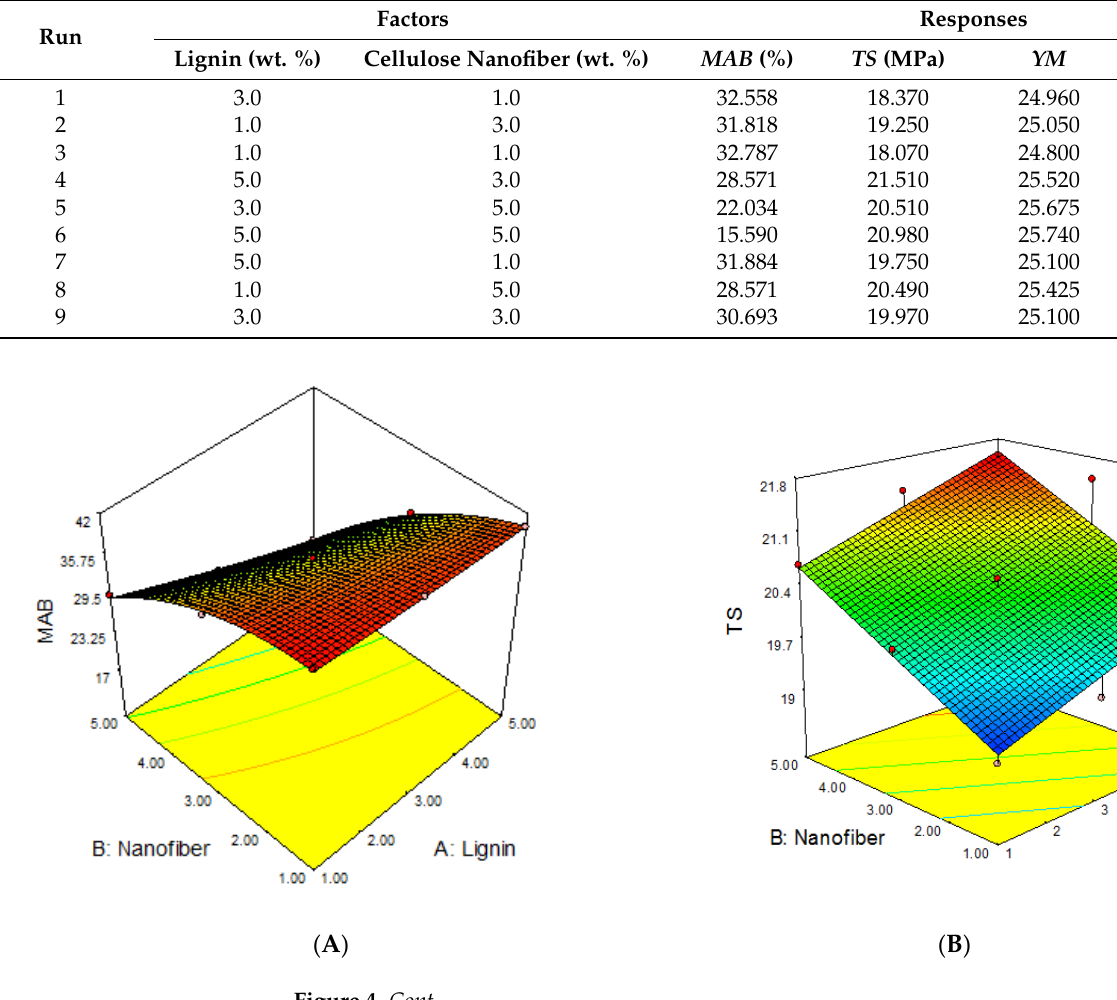
Table 6. RSM factorial design matrix for lignin–cellulose nanofiber-filled thermoplastic starch com- posite film.